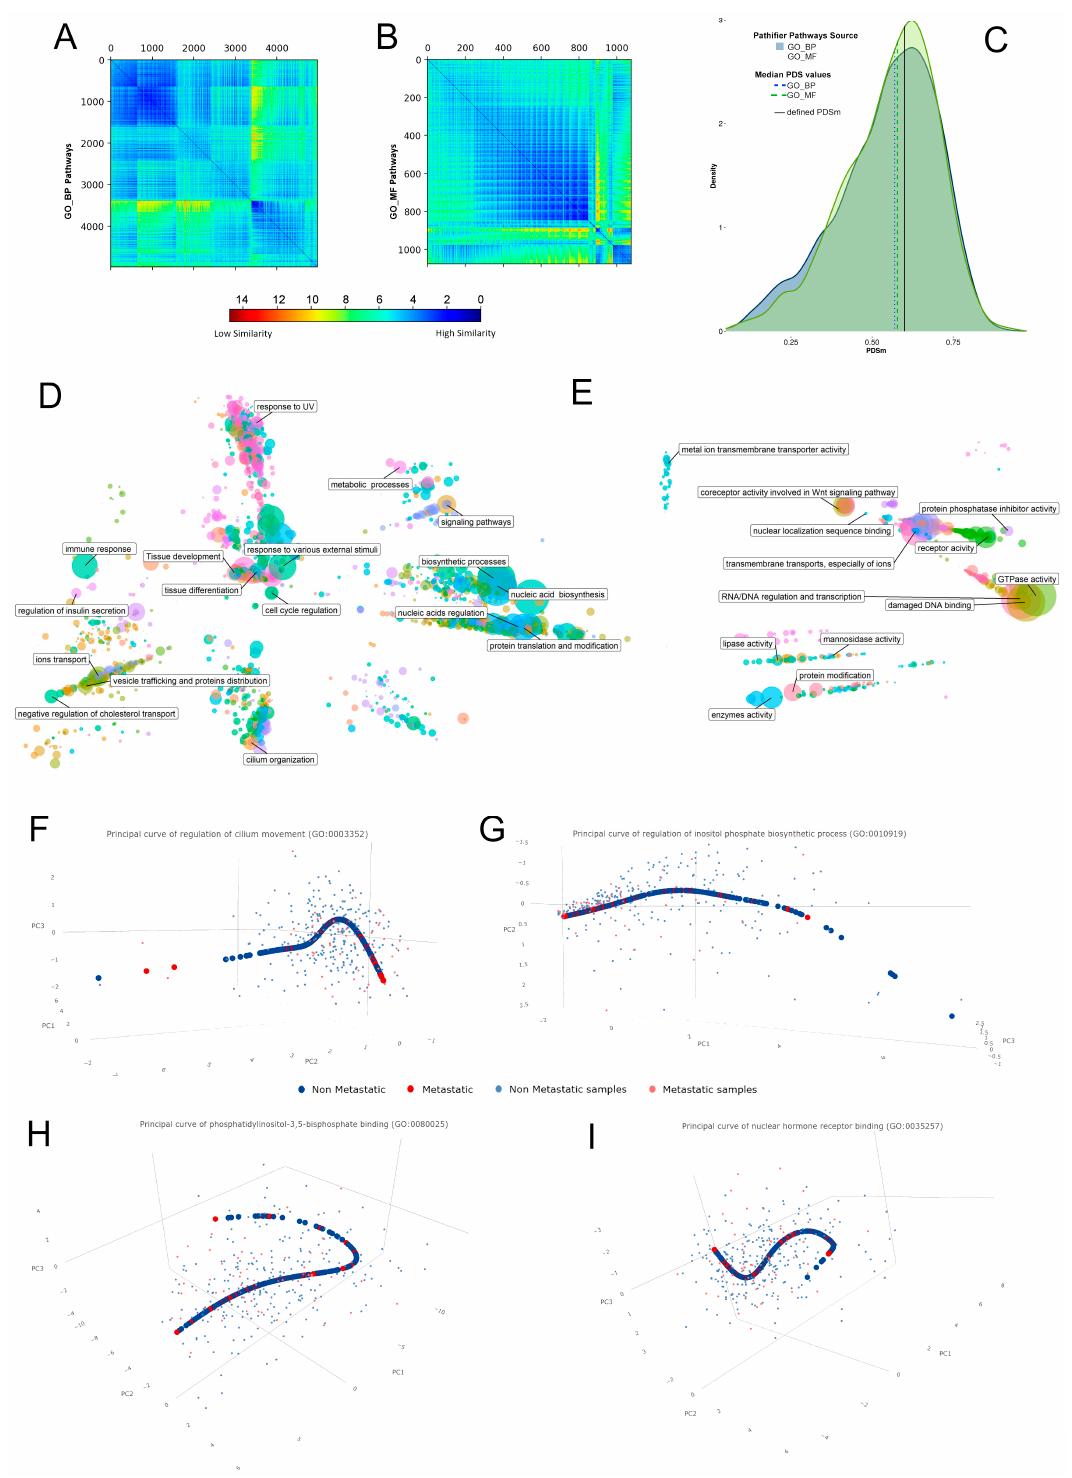
Figure 2. Pathway-based analysis of EC: ( A , B ) Heatmaps representing the distribution of the PDS values from GO_BP and GO_MF, respectively. ( C ) The distribution of PDS values identifies the PDSM value. ( D , E ) Graphical representation of macro-categories encompassing the pathways found significantly altered by Pathifier, relative to GO_BP and GO_MF respectively. ( F – I ) An example of how the cloud of points representing NM and M samples, and the principal curve describing its variation are projected onto the three leading principal components. Four of the most representative pathways found altered are